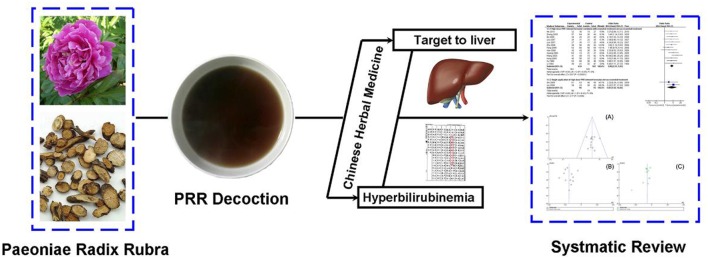
Study flow of Paeoniae Radix Rubra in hyperbilirubinemia. It demonstrated that PRR has been used for the treatment of blood stasis for hundreds of years, as evidenced by records from Ben Cao Gang Mu in 1578 (Ming dynasty). This study was performed to assess the clinical value of high-dose PRR-relevant formulae in the treatment of hyperbilirubinemia.